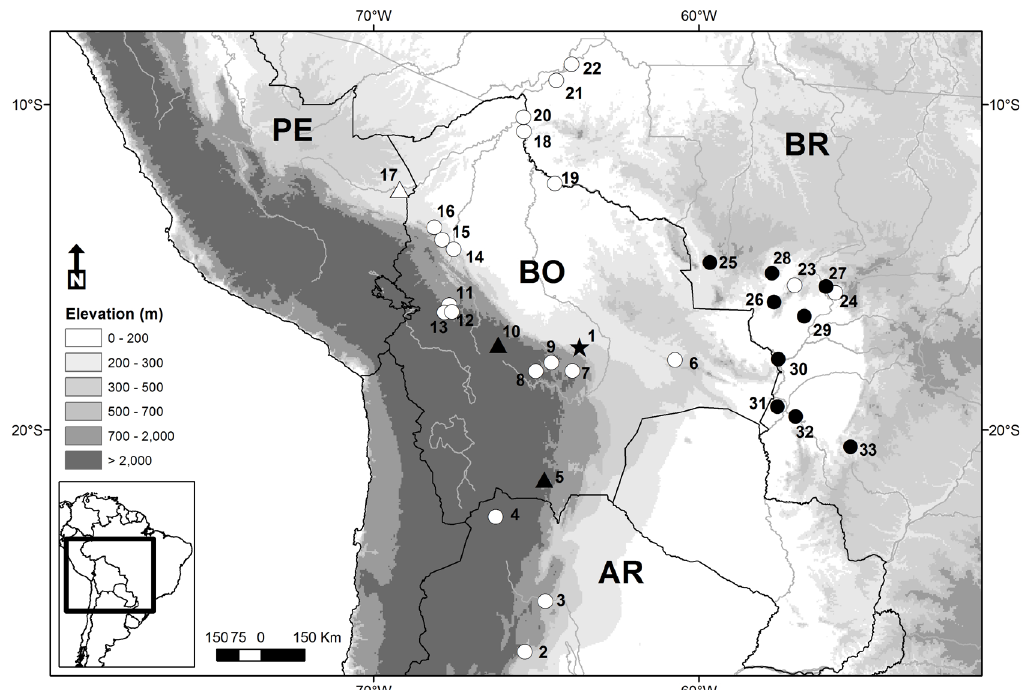
Cercosaura parkeri Distribution of in Argentina (AR), Bolivia (BO), Brazil (BR), and Peru (PE). Star – type-locality: Buenavista (1); open circles – literature records (from Ruibal 1952; Nascimento et al. 1988; Viñas and Daneri 1991; Avila-Pires 1995; Doan 2003; Nogueira et al. 2009; Cristiano Nogueira, unpublished data): Tucuman (2), Salta (3), Jujuy (4), S.J. Chiquitos (Chiquitos; 6), Samaipata (Florida; 7), Villa Granado (8), Comarapa (Manuel M. Caballero; 9), Nor Yungas (11), Chulumani (12), Yanacachi (13), Rurrenabaque (14), Tumupasa (15), Ixiamas (16), Guayaramerin (18), Costa Marques (19), Nova Mamoré (= Vila Murtinho; 20), Jaci-Paraná (21), Porto Velho (22), Porto Estrela (23), Chapada dos Guimarães (24); closed circles – data from the present work: Vila Bela da Santíssima Trindade (25), Cáceres (26), Cuiabá (27), Jangada (28), Poconé (29), Corumbá (Faz. Acurizal, Amolar,